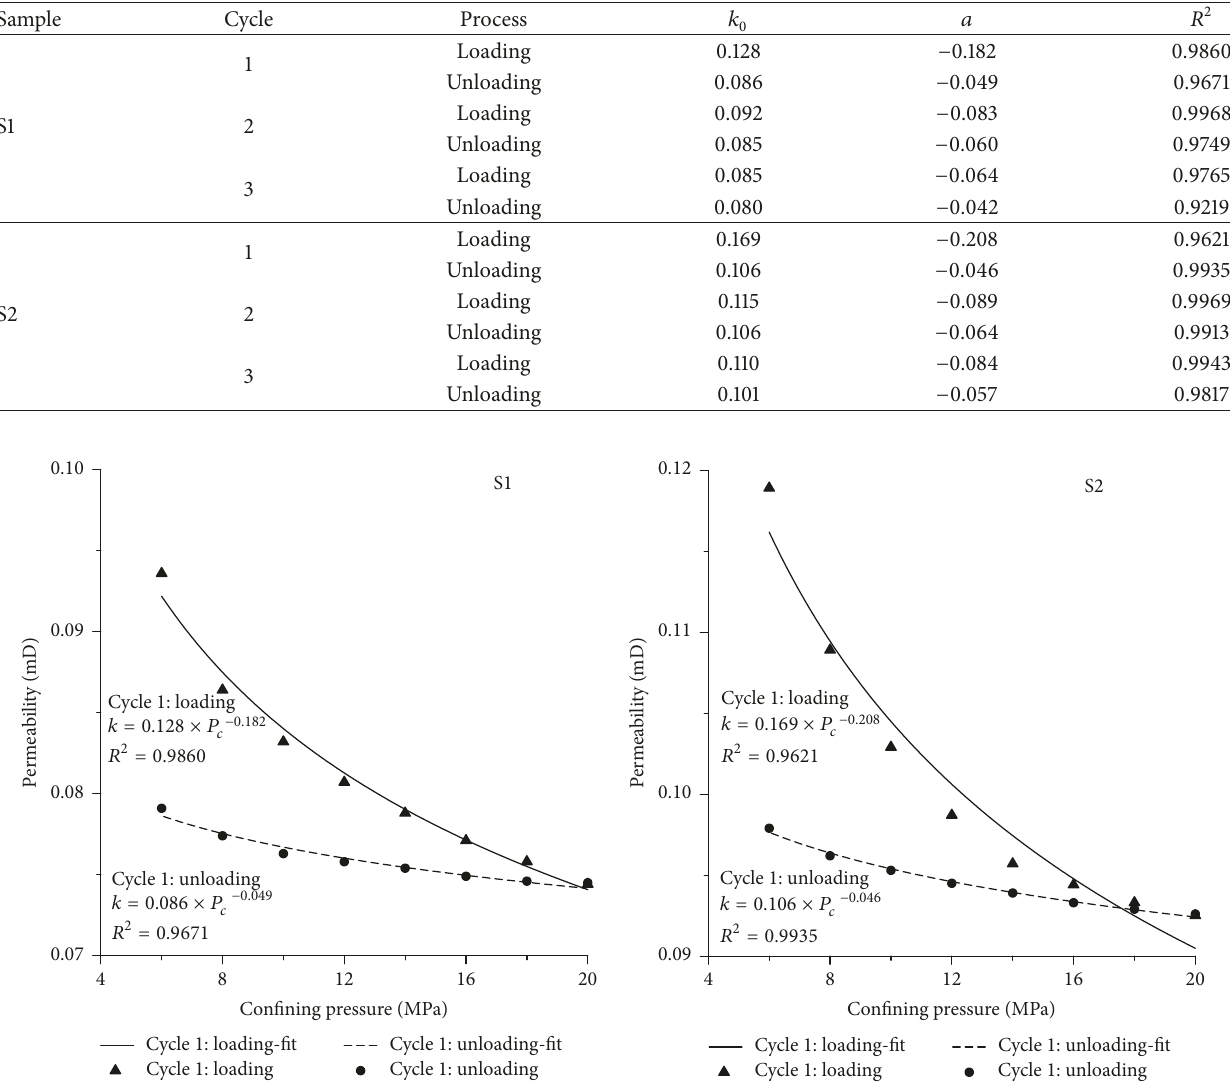
(3) For the same cycle experiment, the rock permeability curves obtained from the loading stage do not fully overlap with those obtained from the unloading stage,